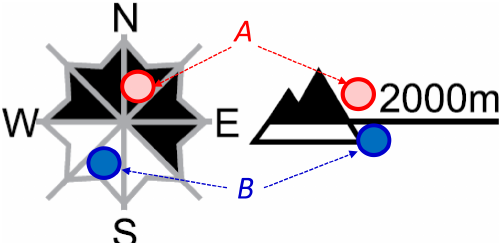
) ≥ 0 . 77 ) is the number of simulated where N( max ( prob unstab